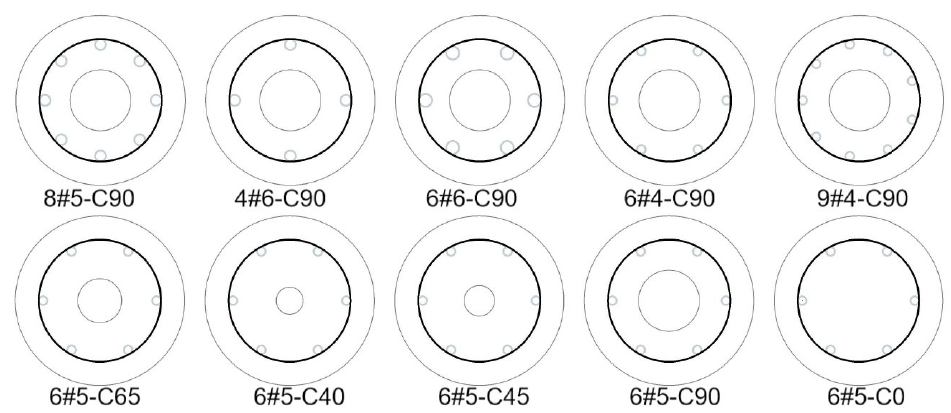
Figure 1. Cross-sectional and GFRP reinforcement details.